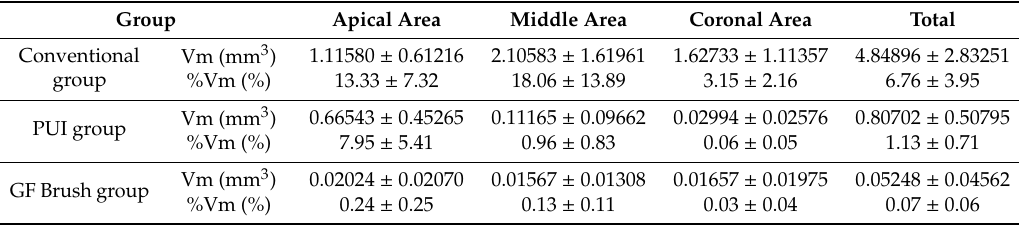
Table 1. Volume and percentage of remaining filling materials in three di ff erent groups.